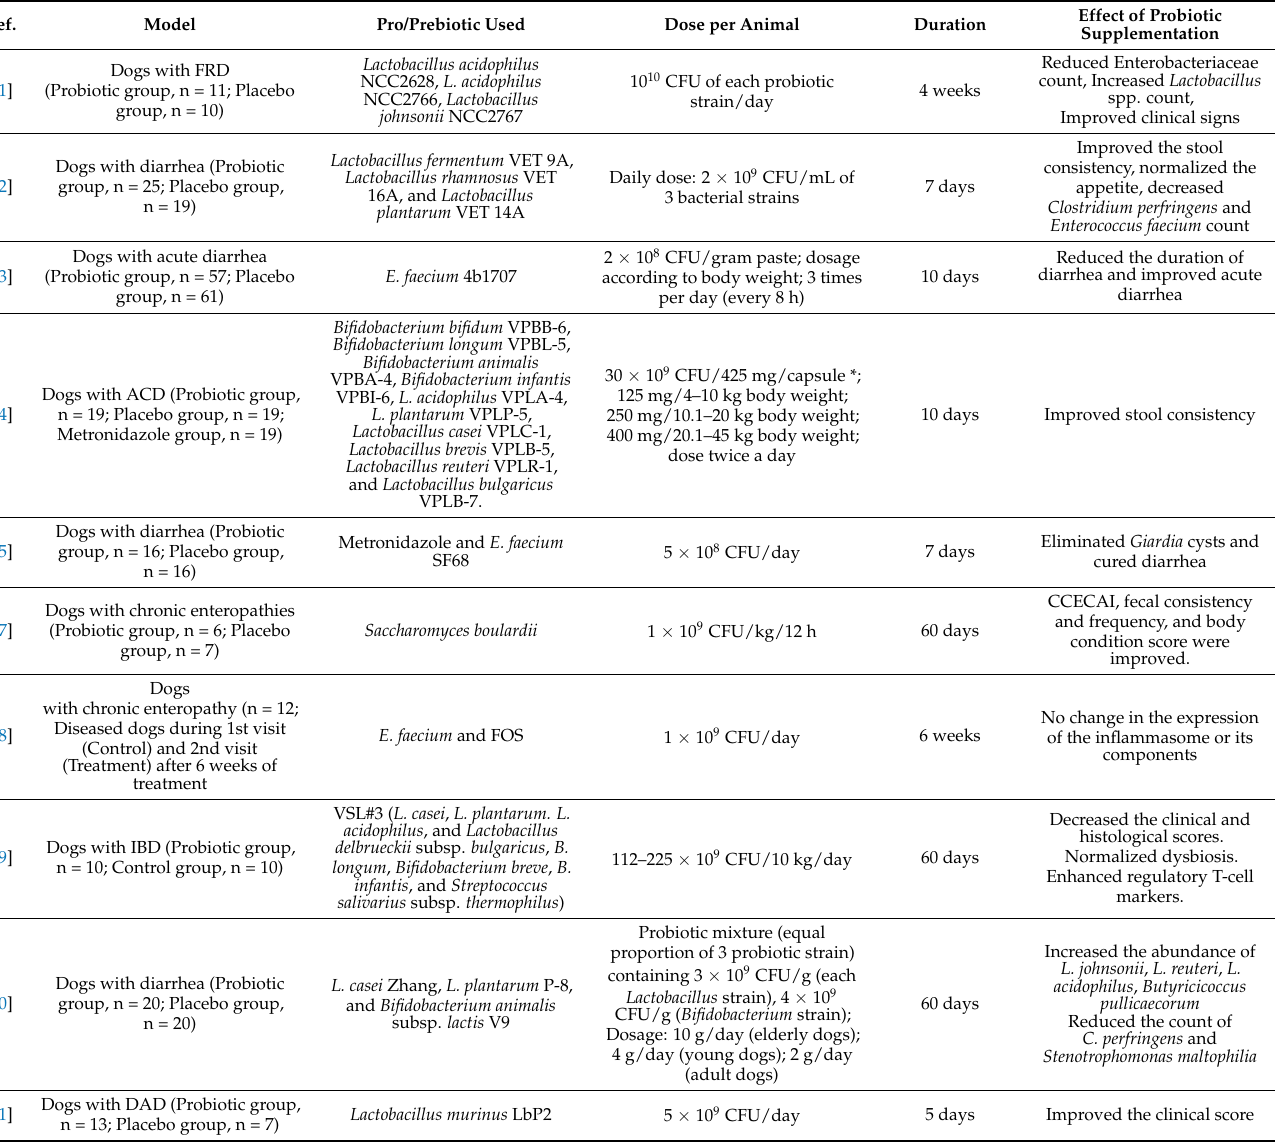
Table 4. The effects of probiotic supplementation on the health status of dogs with gastrointestinal diseases and abnormalities.